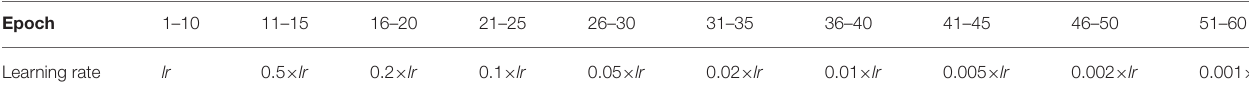
TABLE 5 | Learning rate adopted for training the image classification models with lr = 1e-4. Epoch Learning